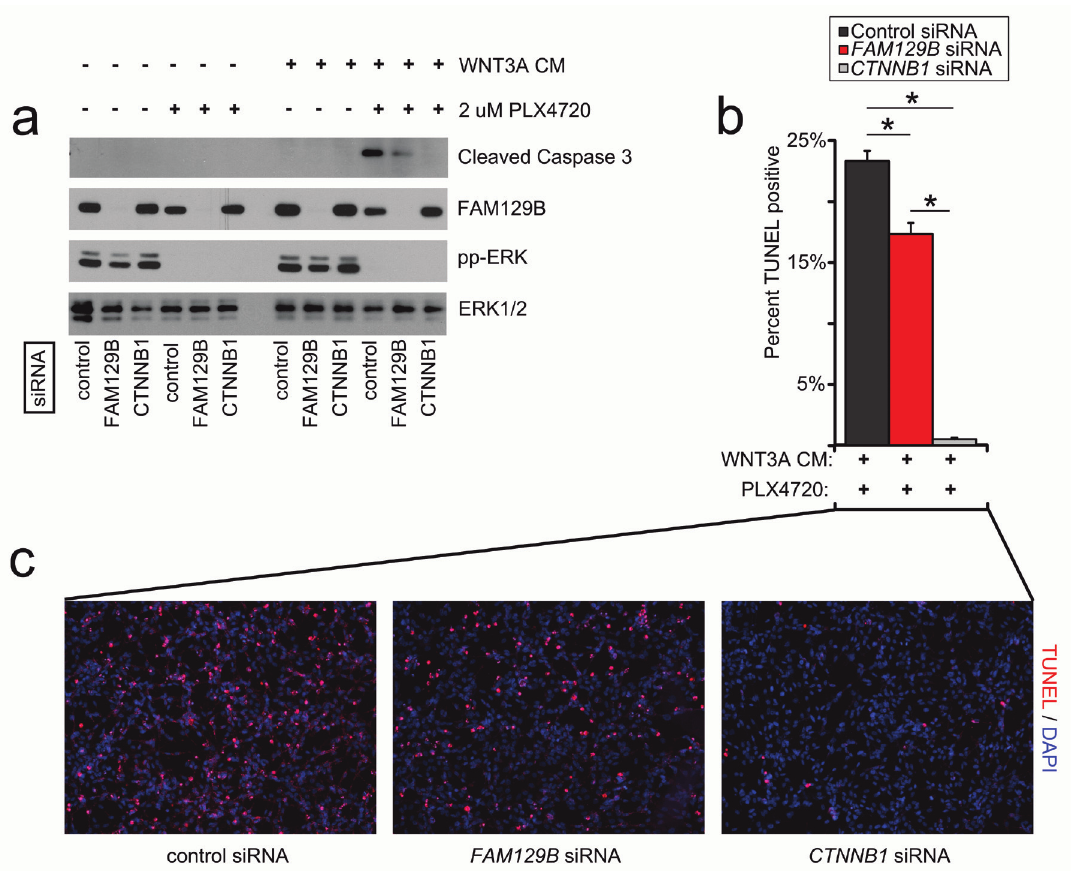
Figure 4. FAM129B positively regulates Wnt/ β -catenin-dependent apoptosis in A375 melanoma. ( a ) FAM129B siRNA inhibits Wnt-dependent apoptosis as monitored by cleaved caspase-3 immunoblot. A375 cells were treated with pooled control, pooled FAM129B siRNA, or CTNNB1 siRNA as indicated for 48 hr. Cells were subsequently treated with DMSO or 2 µM PLX4720, and L-conditioned or WNT3A-conditioned media for 24 hr as indicated. Knockdown of FAM129B was monitored by FAM129B immunoblot, inhibition of ERK/MAPK signaling by phospho-ERK immunoblot, and total ERK was used as normalization. Relative levels of cleaved caspase-3 were quantitated by normalizing cleaved caspase-3 pixel density to ERK1/2 for each condition relative to the maximum cleaved caspase-3 level. Data are representative of at least 3 biological replicates. FAM129B siRNA inhibit cleaved caspase-3 levels to between 16 and 41% of maximum. ( b ) FAM129B siRNA inhibits Wnt-dependent apoptosis as quantified by terminal deoxynucleotidyl transferase-mediated deoxyuridine triphosphate nick end labeling (TUNEL) immunofluorescence (IF). A375 melanoma cells were treated as above, fixed and stained using TUNEL. Percent TUNEL positive cells calculated as a percent of DAPI positive cells. ( c ) Representative immunofluorescence of A375 cells treated with the indicated conditions. TUNEL staining is depicted in red and DAPI staining is depicted in blue. Columns and error bars represent the mean and SEM of three separate biological replicates. *p<0.05 by student’s